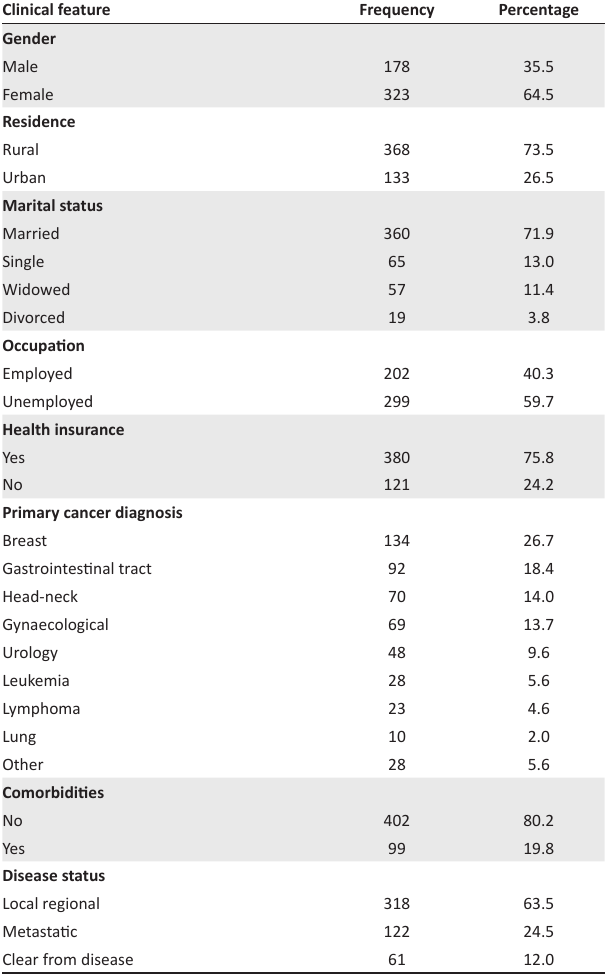
TABLE 1: Demographic and clinical characteristics ( N = 501). Clinical